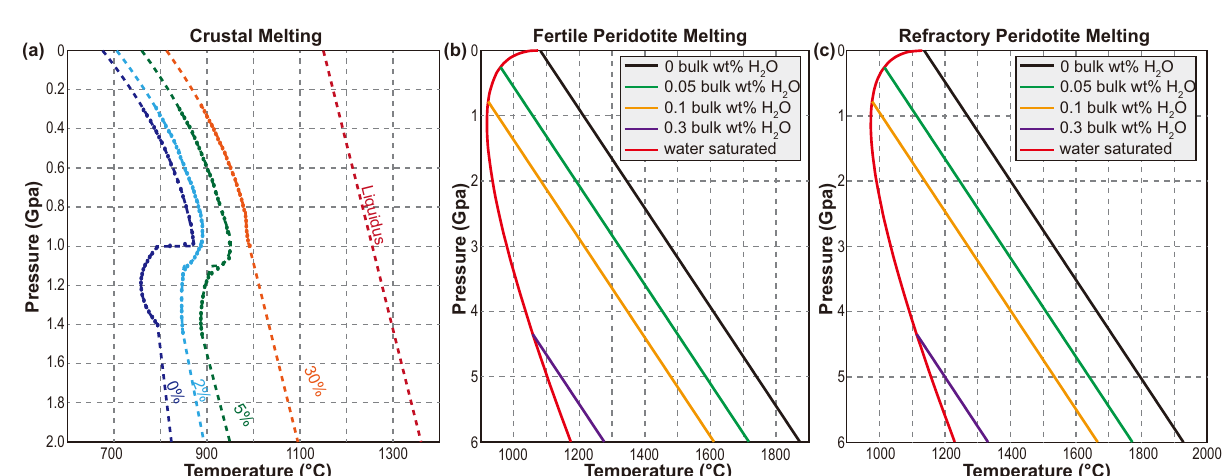
Fig. 10 | Solidi for the crustal and mantle materials 56,62 . a The solidus for the crustal materials is based on lab experiments 73 . 2% means that amphibolite has experienced 2% melting.Liquidusequals 100% melting degree. b , c The solidus for themantlematerialsisbasedonMorgan(2001)andKatzetal.(2003). “ 0.1bulkwt. % “ refers to the water content we use for calculating the solidus. The fertile